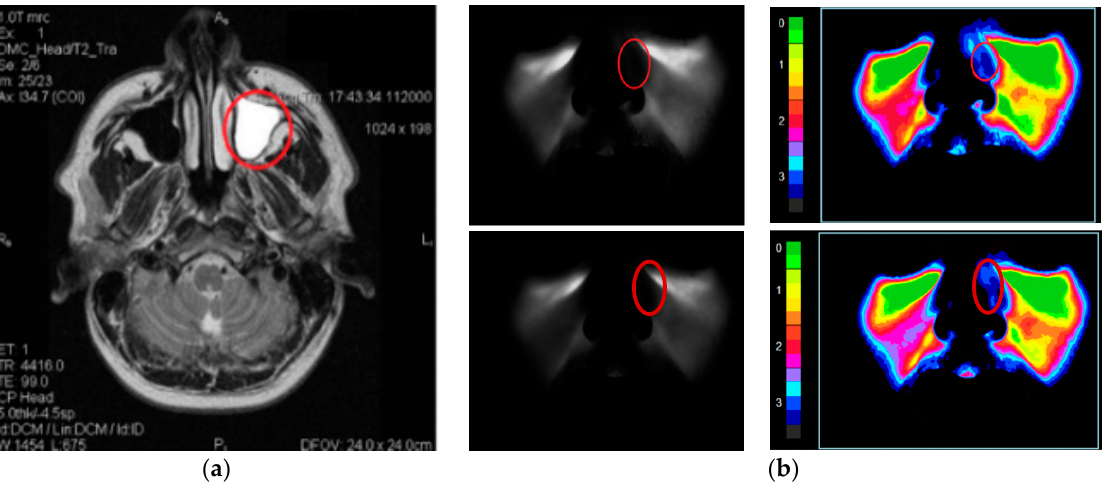
Figure 4. The T2 weighted MRI image ( a ); and the images registered and processed by diaphanoscopy ( b ) for a patient (male) at radiation wavelengths of 650 nm ( top ) and 850 nm ( bottom ).